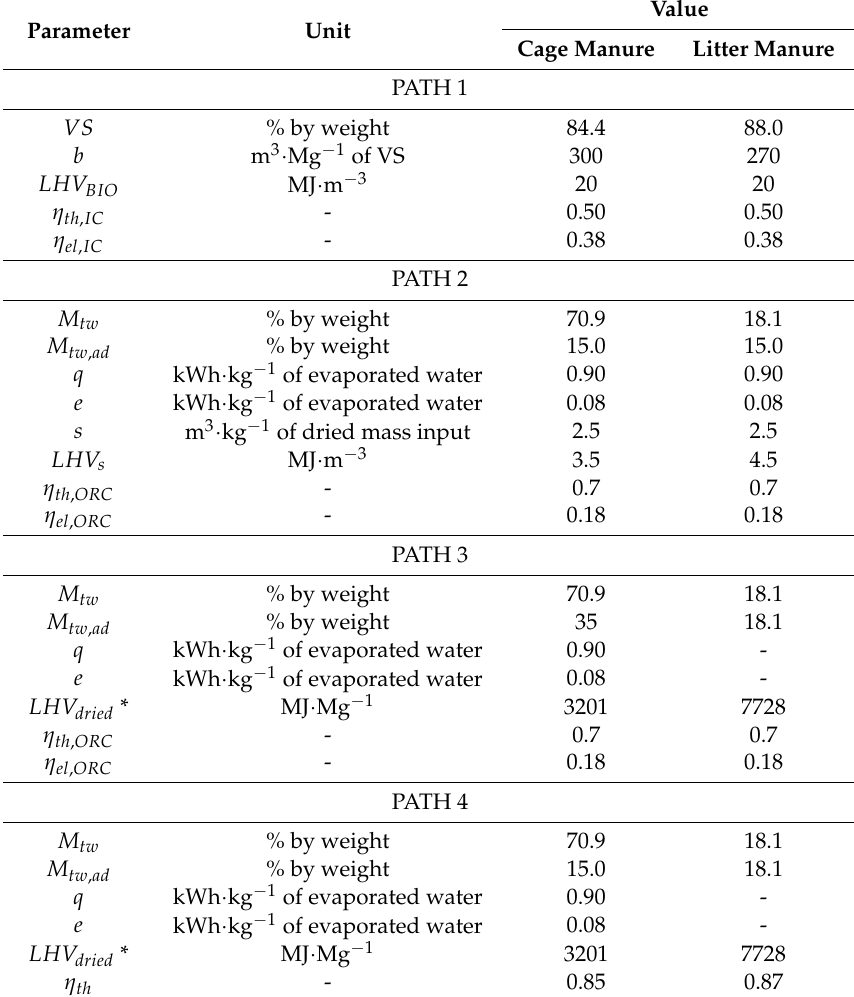
Table 5. Input data for technical potential calculation according to assumed conversion paths. Parameter